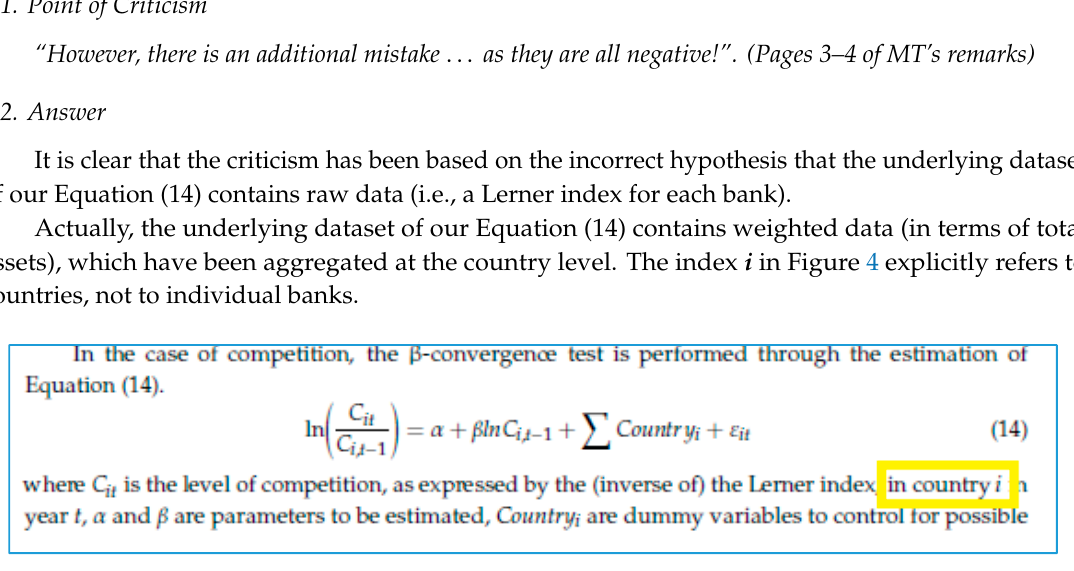
Figure 4. The β -convergence test with respect to competition.